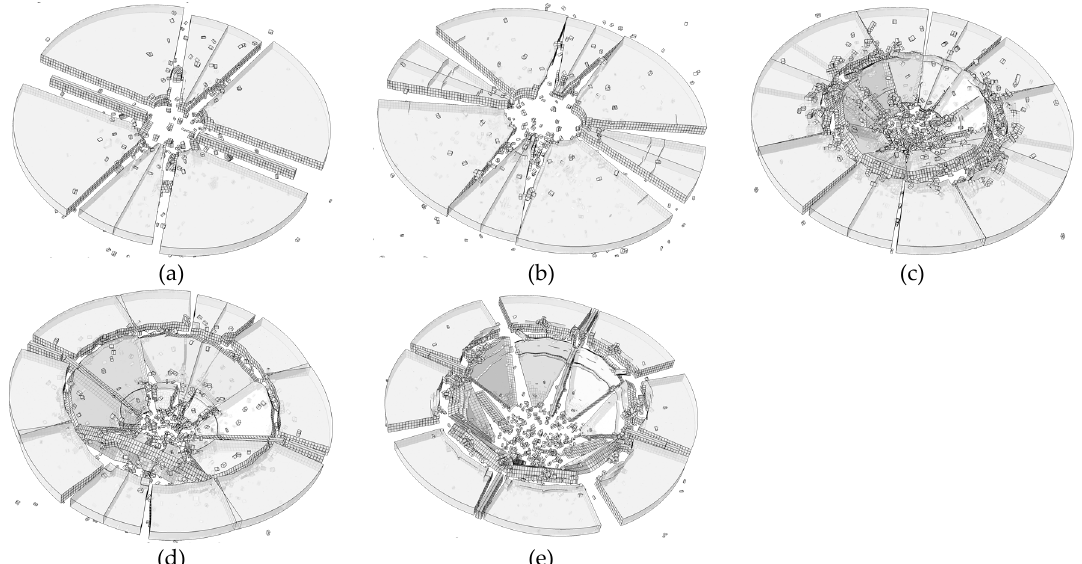
Figure 13. Effect of initial velocity on the results ( a ) v0 = 0.50 m/s; ( b ) v0 = 1.00 m/s; ( c ) v0 = 1.98 m/s; Figure 13. E ff ect of initial velocity on the results ( a ) v0 = 0.50 m / s; ( b ) v0 = 1.00 m / s; ( c ) v0 = 1.98 m / s; ( d ) v0 = 3.00 m/s; ( e ) v0 = 4.00 m/s. ( d ) v0 = 3.00 m / s; ( e ) v0 = 4.00 m /